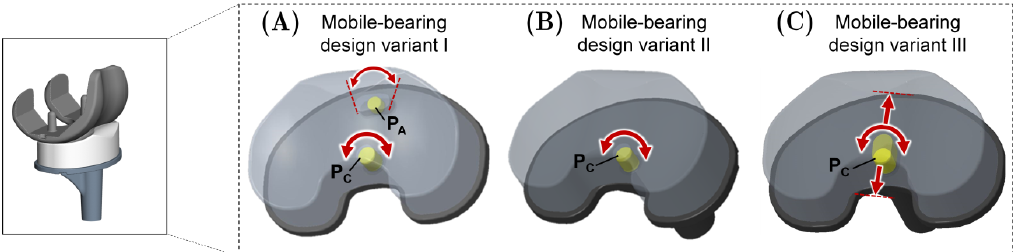
Figure 3. Mobile-bearing (MB) total knee replacement design variants investigated in this study.